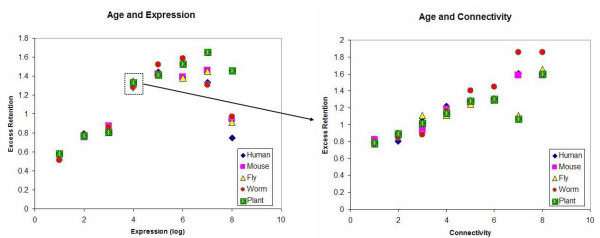
Age and Connectivity when controlling for Expression. To control for expression, a bin of proteins is selected from the Age and Expression graph. The proteins in this bin are reanalysed to check if the correlation between age and connectivity still remains. This stratification demonstrates that expression levels have very little effect on the relationship we observe between age and interactions ρ: 0.91762).